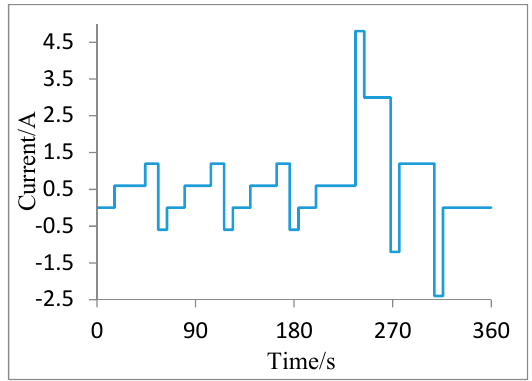
Figure 3. Current prolife of DST.